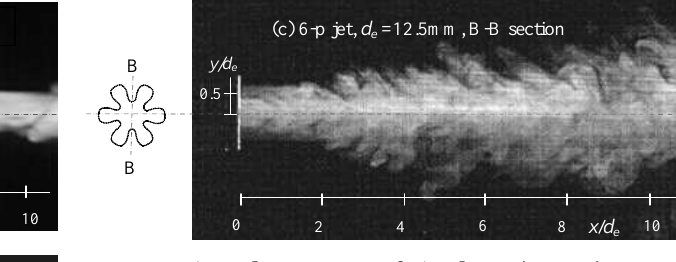
Fig.3 Flow patterns of circular and 6-p submerged water jets, Re = 3,000 ( d = d